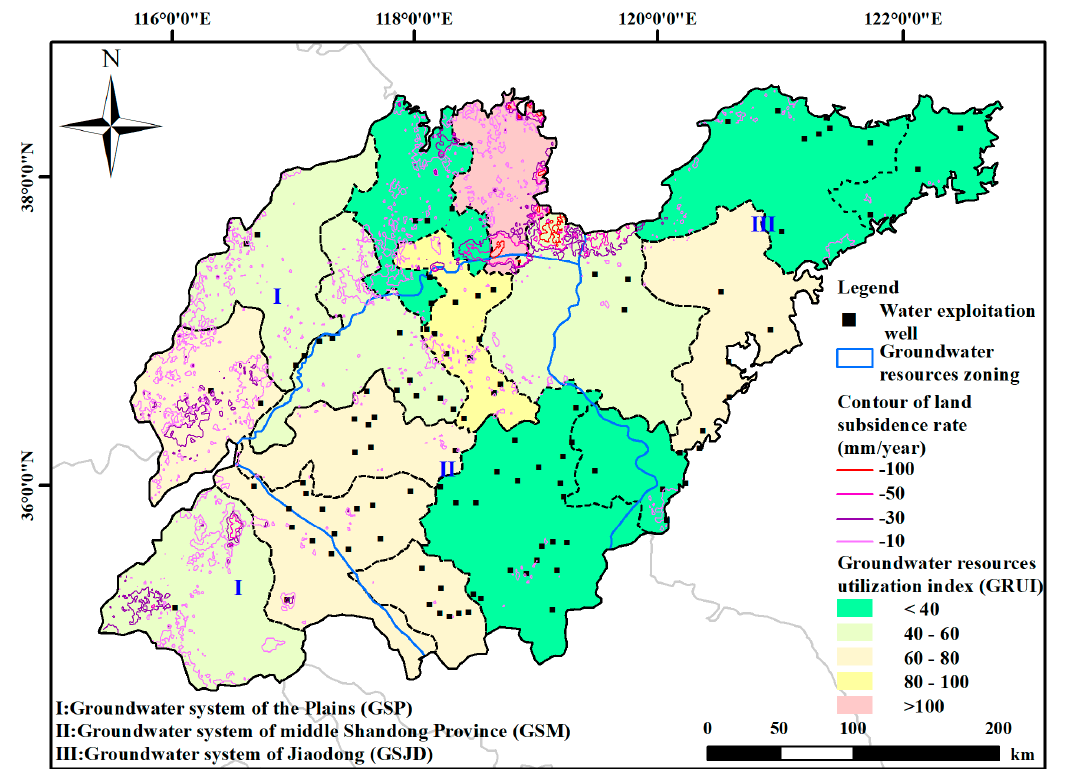
Figure 8. Relationship between groundwater exploitation and land subsidence.